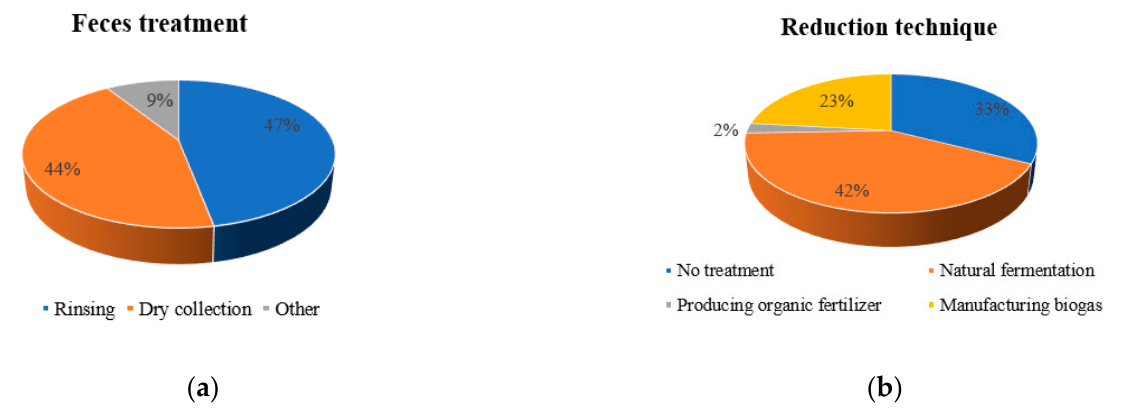
Table 3. Demographic characteristic of surveyed